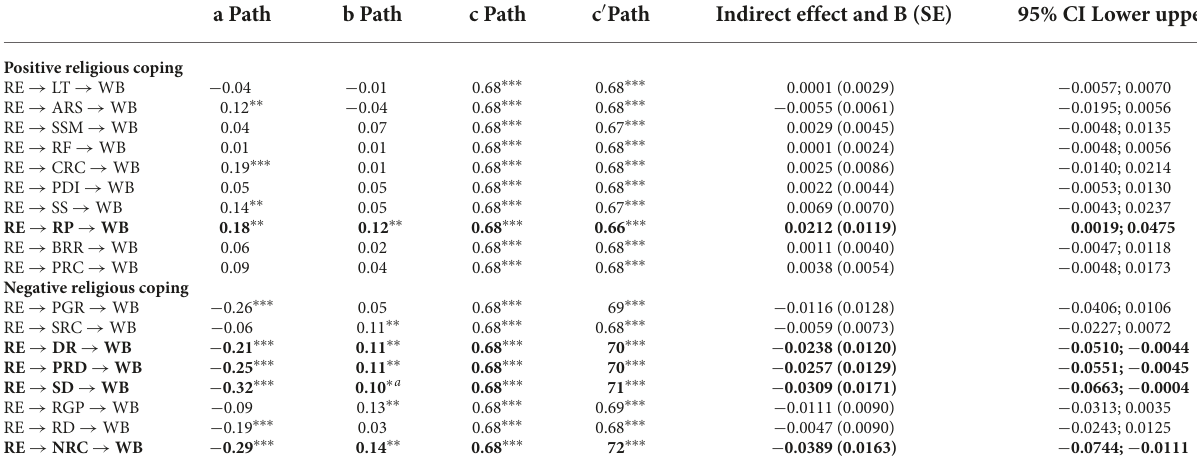
TABLE 3 The role of religious coping strategies on resilience and mental well-being ( N = 317). a Path b Path c Path c (cid:48) Path Indirect effect and B